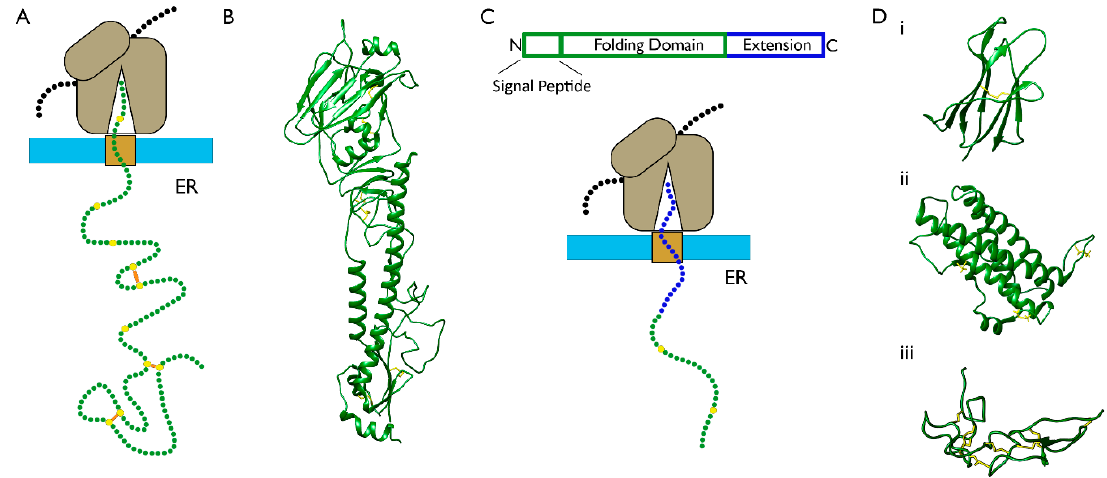
Figure 3. Model proteins to study co-translational disulfide bond formation. ( A ) Schematic showing an ER-targeted, ribosome-associated nascent chain complex in which disulfide formation takes place before translation is complete. ( B ) Ribbon diagram representing the three-dimensional (3D) structure of the haemagglutinin ectodomain (HA) monomer (Protein Data Bank (PDB) 1HA0). ( C ) Extensions to proteins at the C-terminus enable full translocation of the N-terminal domain while the C-terminus remains ribosome-attached. ( D ) Ribbon diagrams representing the 3D structures of ( i ) β 2M (PDB 1A1M), ( ii ) prolactin (PDB 1RW5), and ( iii ) the disintegrin domain of ADAM10 (PDB 6BE6).